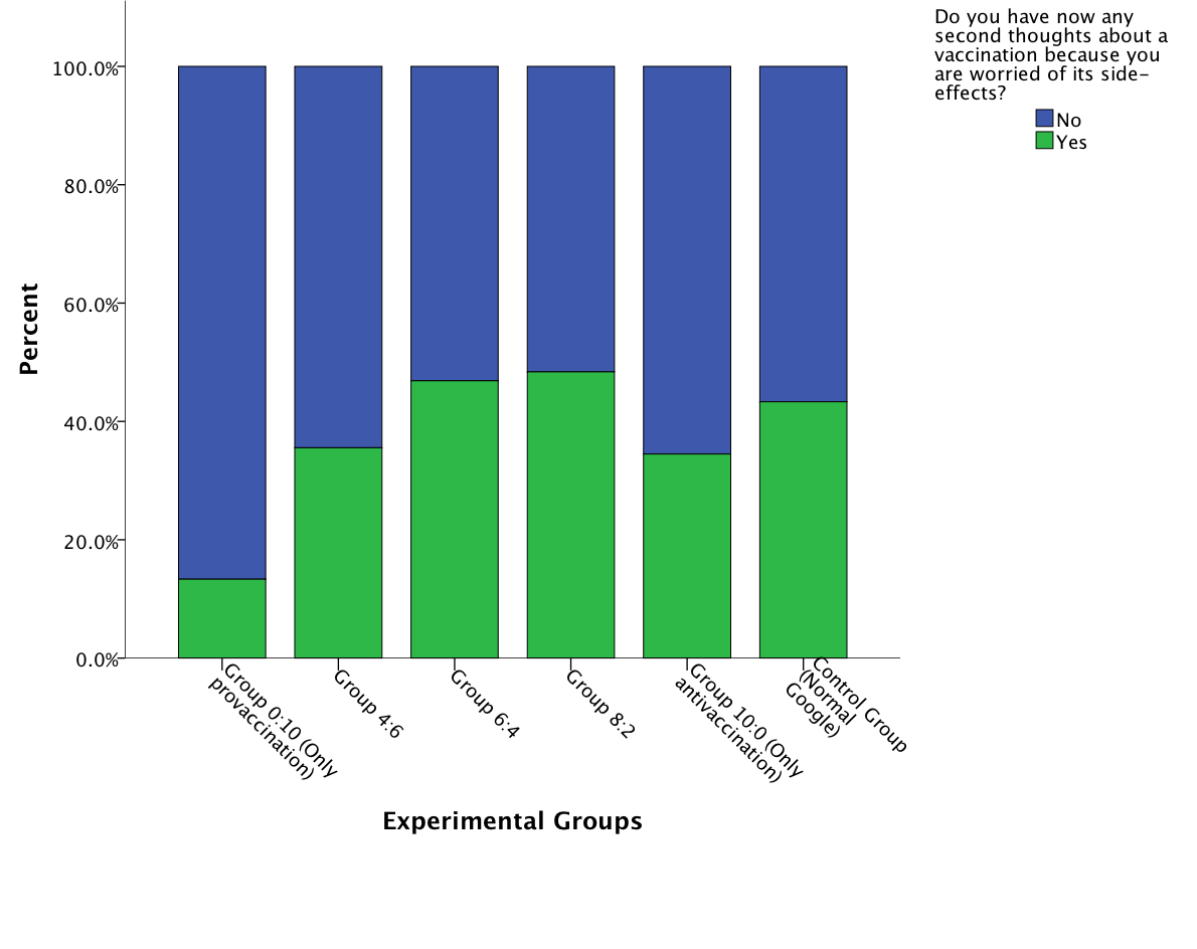
Figure 5. Bar graph of perceived persuasive effect of information retrieved by experimental